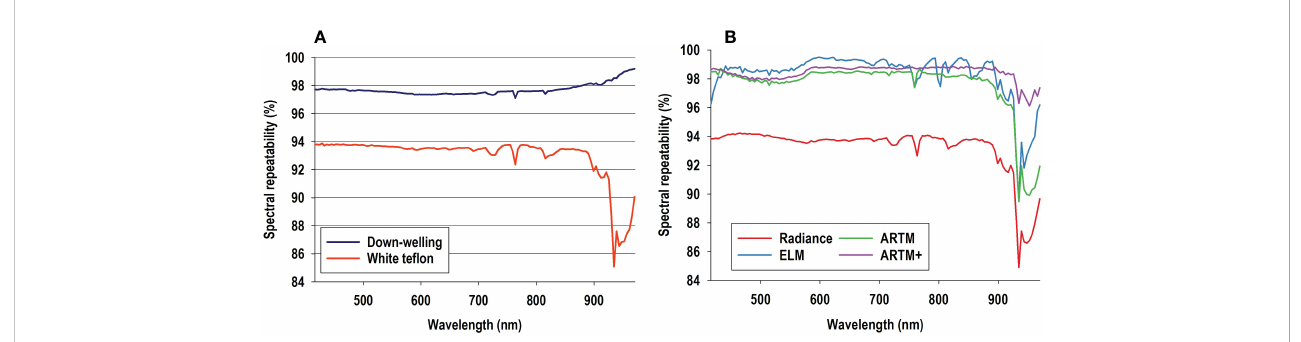
FIGURE 3 Equation 1 was used to calculate spectral repeatability of irradiance pro fi les (acquired with drone-mounted down-welling sensor) and of radiance pro fi les from white Te fl on from 52 fl ight missions (A) . Equation 1 was also used to calculate spectral repeatability of pro fi les from red color panel based on four levels of spectral calibration (B) : 1) no spectral calibration (radiance data), 2) spectral calibration based on white calibration boards (empirical line method, ELM calibration), 3) spectral calibration with irradiance data acquired with a drone-mounted down-welling sensor (ARTM), and 4) modeled sun parameters and weather variables in combination with irradiance data from drone-mounted down-welling sensor